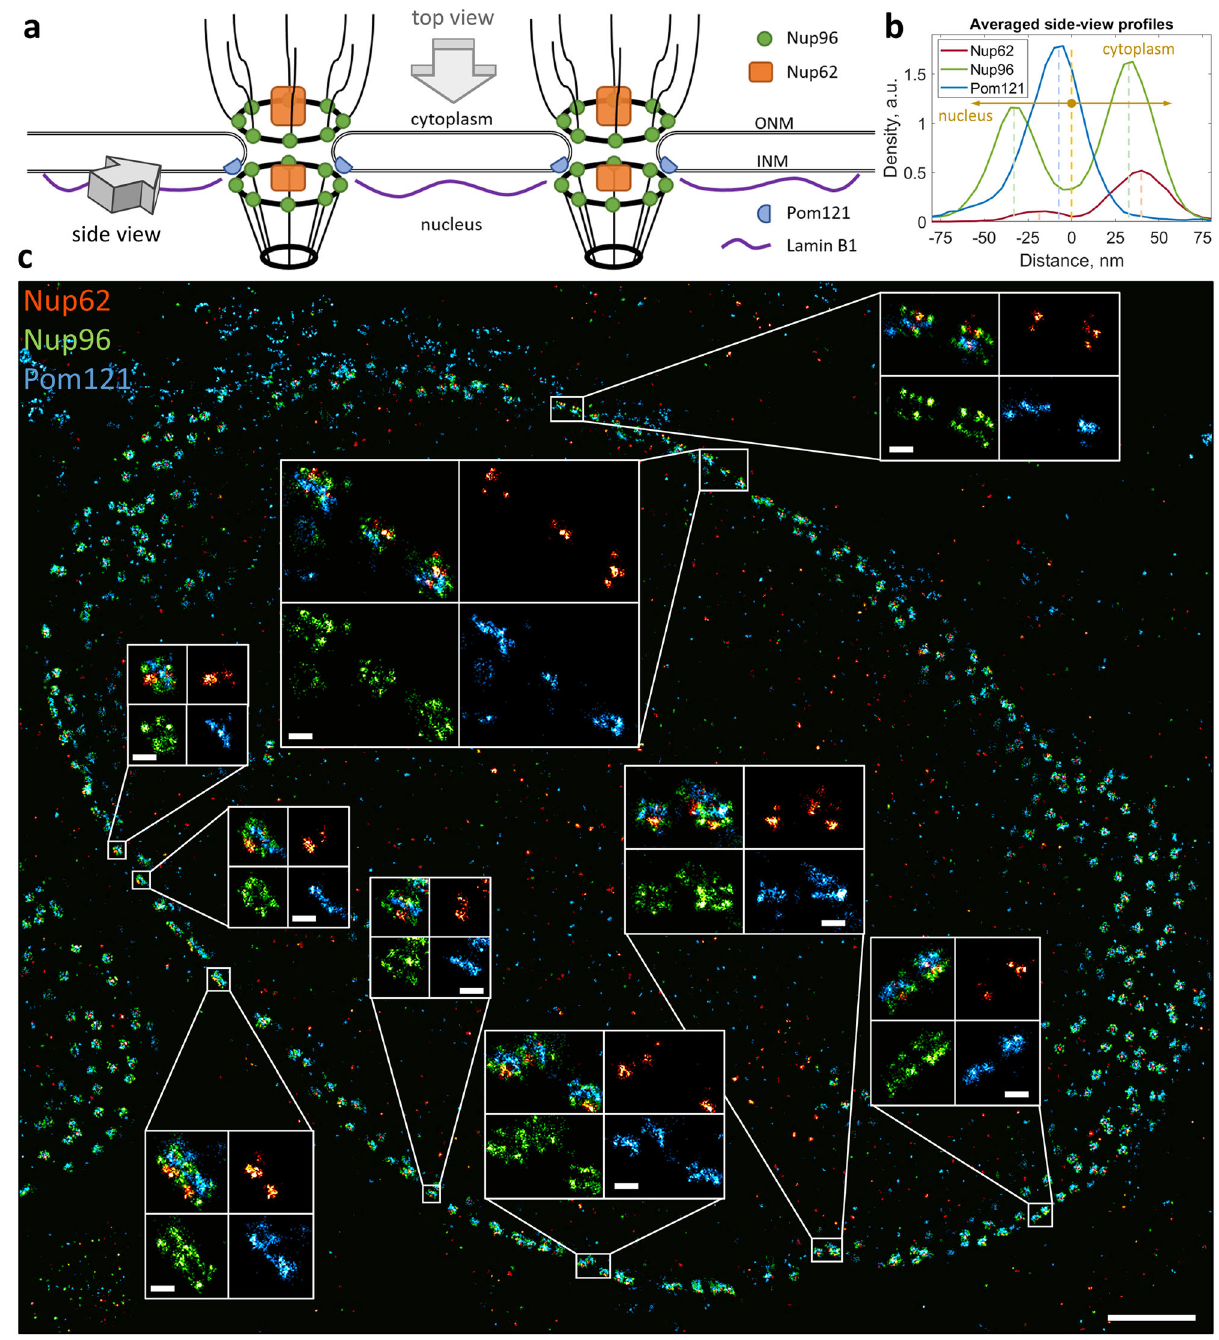
Fig. 3 “ Side view ” of the NPCs with Nup96, Nup62 and Pom121 imaged by splitSMLM. a Scheme of the NPCs at the NE. ONM, outer nuclear membrane; INM, inner nuclear membrane. b Averaged “ side view ” pro fi les of Nup62, Nup96 and Pom121 obtained by alignment of 65 individual NPCs. c U2OS cell with immuno- fl uorescently labeled Pom121 (blue), Nup62 (red) and Nup96 (green) with zoomed-in “ side view ” regions in insets. Scale bars, 1 µ m ( c ) and 100 nm